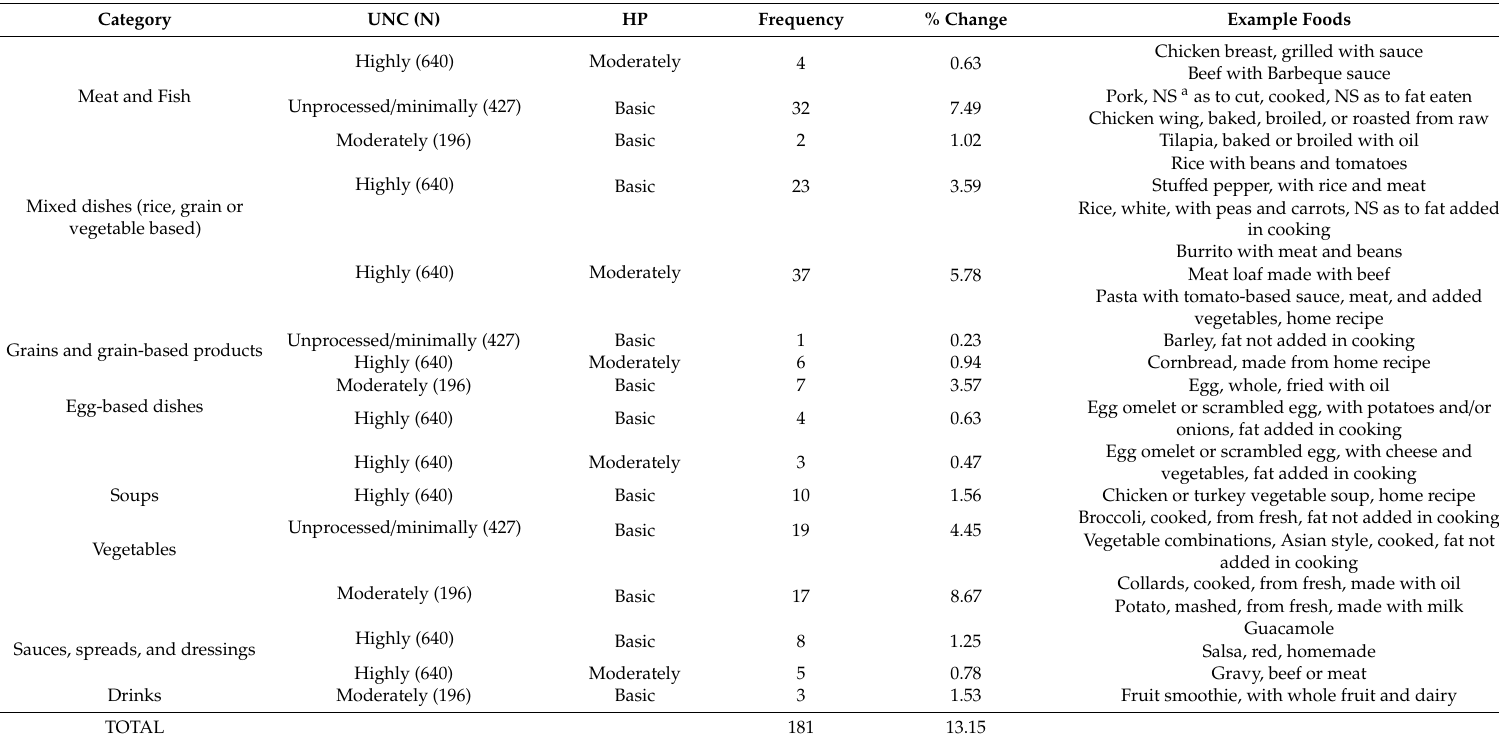
Table 4. Frequency of coding discrepancies by food category between the University of North Carolina at Chapel Hill (UNC) 21 and adapted home processing (HP) frameworks for foods from 100 randomly selected dietary recalls, NHANES 2015–2016 (N =